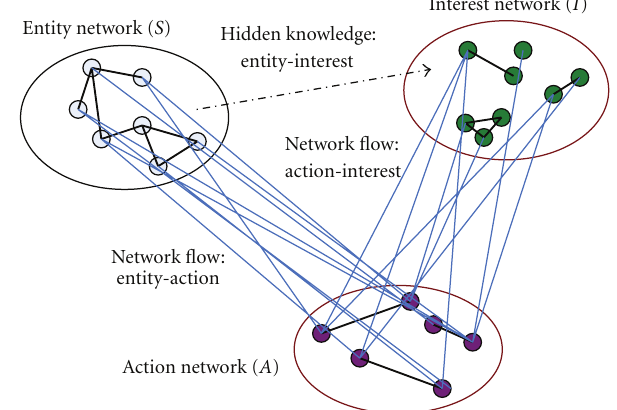
Figure 1: Supernetwork based relationship model among entities in social